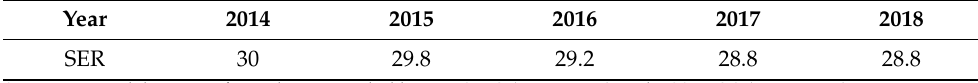
Table 3. Annual social expenses (over GPD) by Belgium in the period 2014–2018.